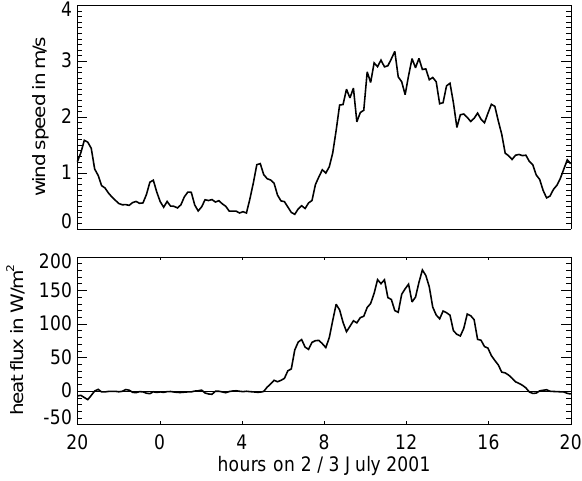
Figure8:Potentialtemperaturepro(cid:28)lesover24hatMuni hairporton2/3July2010.